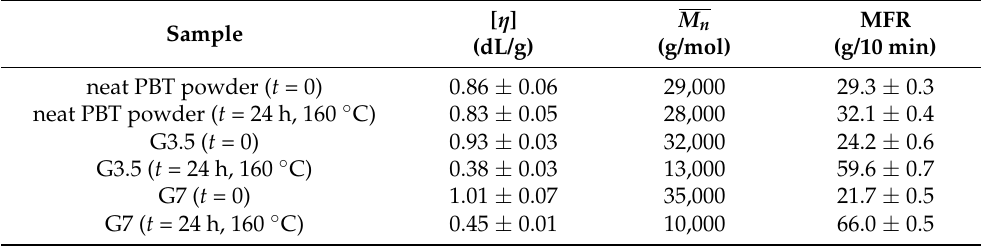
Table 1. Intrinsic viscosity [ η ], M n and melt flow rate (MFR) of the neat poly(butylene terephthalate) (PBT) powder, the physical mixtures (G3.5, G7) and the relevant alcoholysis products ( t = 24 h, 160 ◦